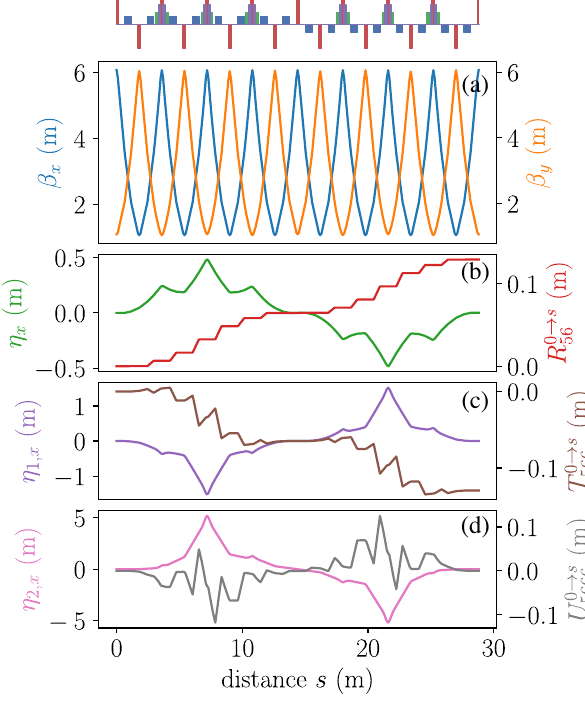
FIG. 9. Layout of bunch compressor BC1 (top diagram) with evolution of associated betatron function (a) and pertinent linear (b), second-order (c), and third-order (d) transfer-map elements along the beam line (with s ¼ 0 corresponding to the beginning of BC1). In plots (b) – (d) the left and right axes refer to the horizontal chromatic functions η and accumulated longitudinal i;x transfer-map elements from 0 to location s along BC1. In the top diagram the red, blue, green, and purple rectangles correspond, respectively, to quadrupole, dipole, sextupole, and octupole